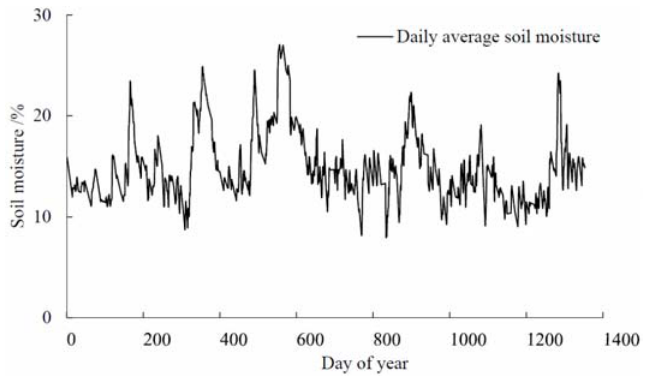
Figure 5. Daily average soil moisture in the calibration period.